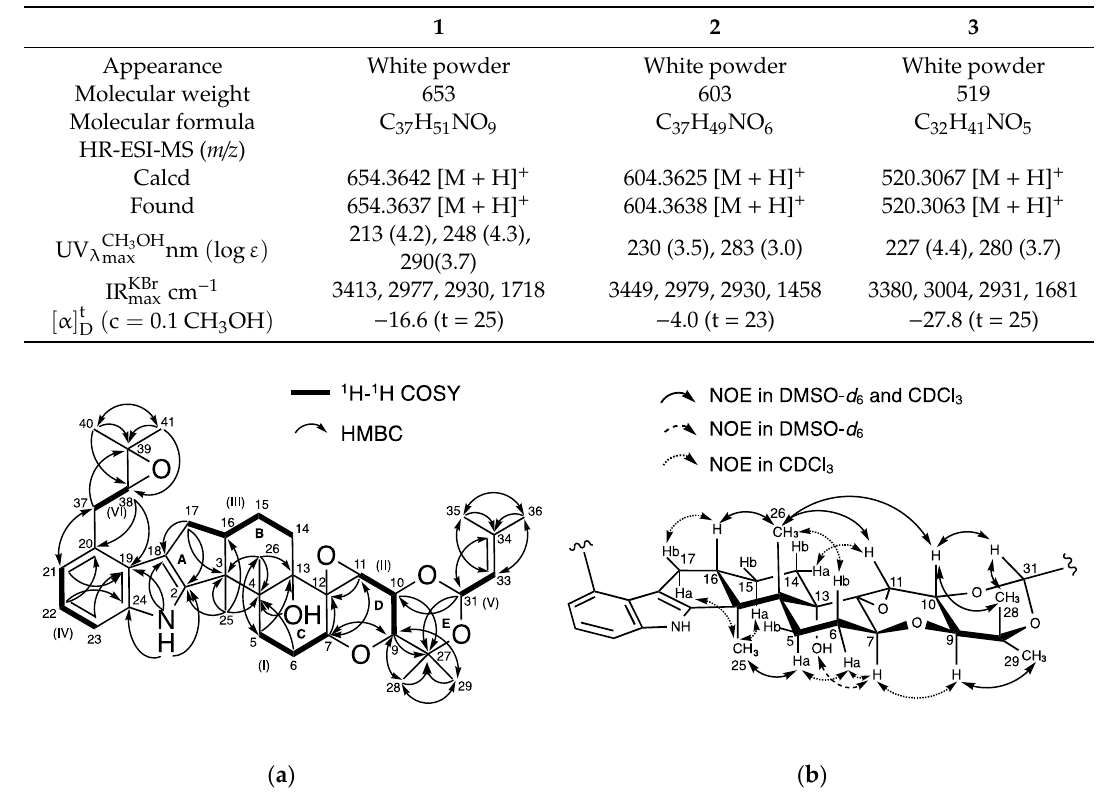
Table 1. Physicochemical properties of 1–3 .